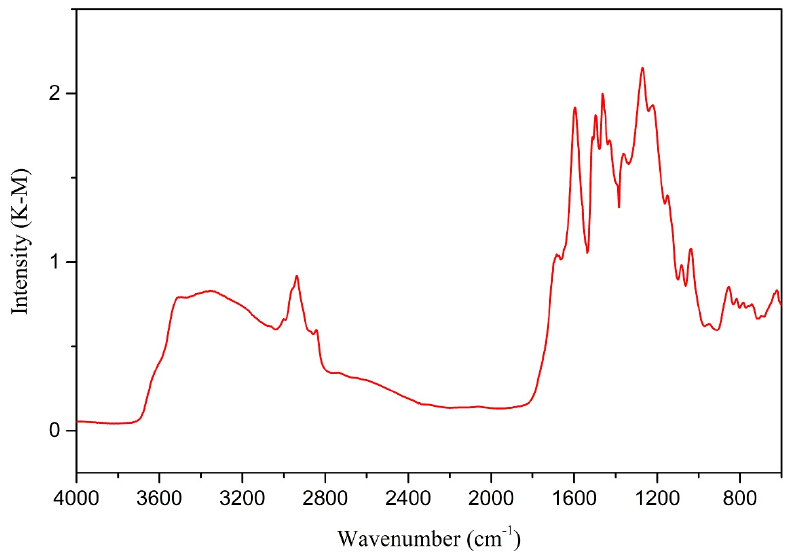
Figure 3. FTIR spectra and the available peaks of char from 573 K and 10 min residence time.